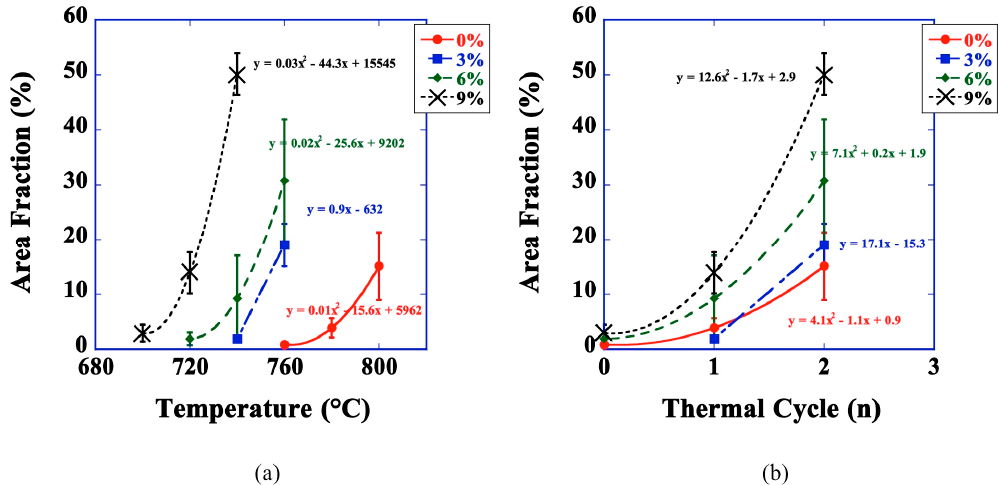
Figure 7. Area fraction of abnormally growing grains for 0%, 3%, 6%, and 9% induced strain as a function of ( a ) temperature and ( b ) thermal cycle. Table 1. Emergence and progression rates for abnormally growing grains.